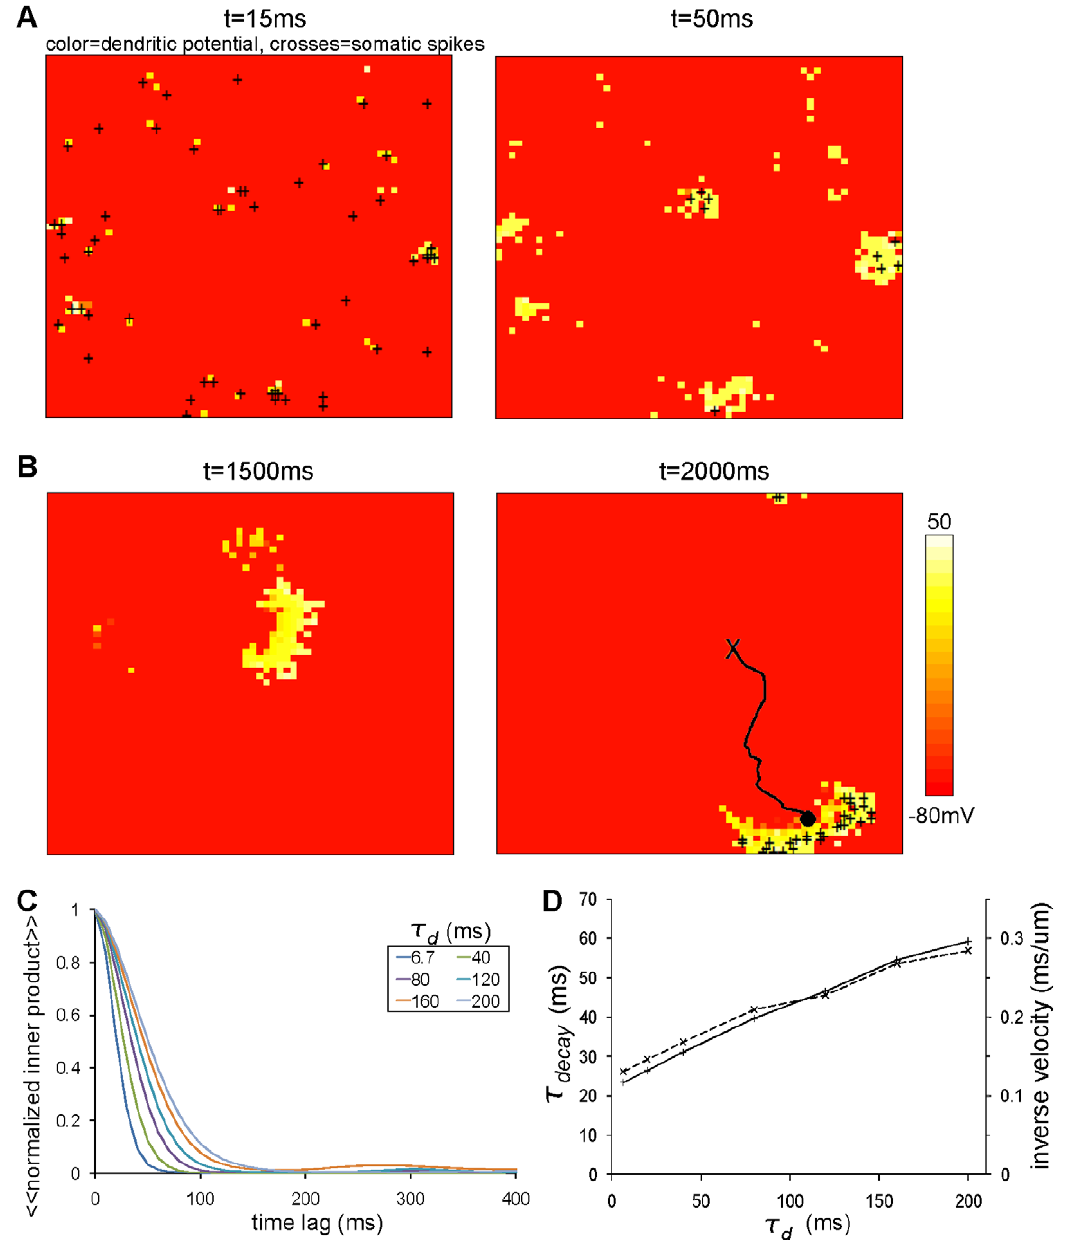
Figure 2. Spontaneous arising and moving of bump activity with noiseless background input. (A and B) The activity of the two-field model with noiseless background input (noiseless condition). Each panel is an overlaid view of the activity of somatic and dendritic fields. Heat-color at each location represents the value of the dendritic potential of the dendritic unit sitting at the corresponding location. The crosses indicate where somatic spikes occur at that time. Throughout the paper, panels of this type always represent 3 mm | 3 mm of the dendritic/somatic fields. The dendritic time constant was t d ~ 200 ms. The intensity of the noiseless background current was set to m c onst ~ 5 : 0 pA. (A) Spontaneously arising of small bumps. First at t ~ 15 ms the neural activity was sparse (left), then the neural activity was spontaneously clustered and some small bumps were born by t ~ 50 ms (right), which were later combined into a sizable bump by t ~ 1500 ms as in (B). (B) Spontaneous moving of a bump. The bump sitting near the center of the field (left panel) moves to the lower right (right panel). In the right panel, ‘X’ marks the center of the bump shown in the left panel, the black dot marks the center of the bump at 2000 ms, and black line represents the trajectory of the bump. No crosses appeared at 1500 ms accidentally. (C) The inner product of somatic activity patterns showing rapid decay with a time lag for all of the values of t d . The curves were obtained by temporal and trial average of the inner products (denoted by SS : TT ). (D) The decay constant increased almost linearly with t d . The decay constant was obtained from exponential fitting of the inner products in C (solid line). The overlaid dashed line indicates the inverse of the velocity of the center-of-gravity of the bump.